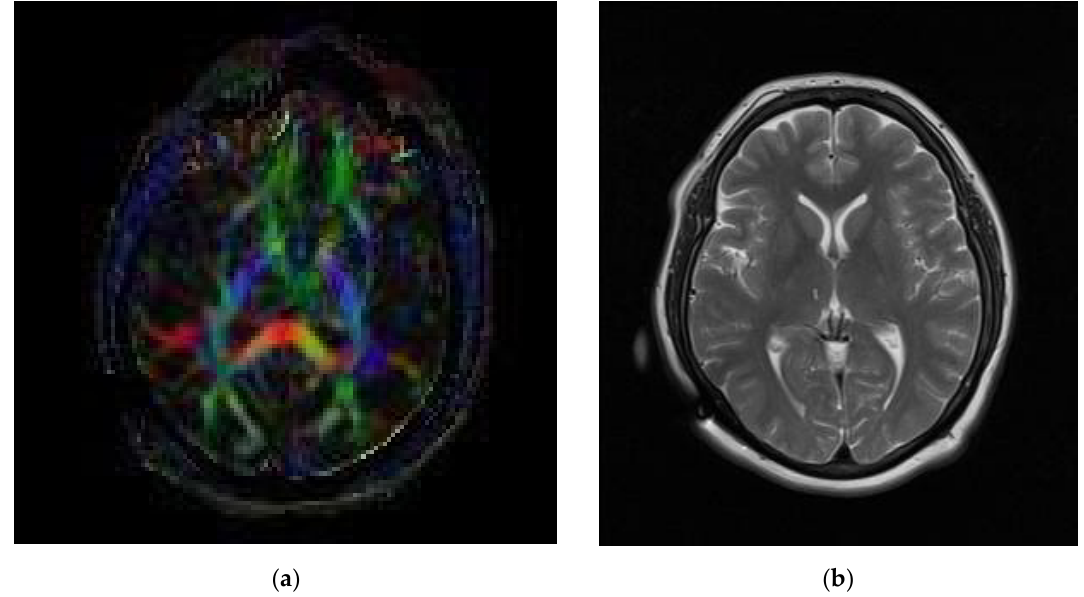
Figure 2. ( a ) A DTI showing tracts surrounding the left centro-median lesion. ( b ) Postoperative T2 MRI sequence showing a rounded lesion at the centro-median nucleus 6 months after the procedure.